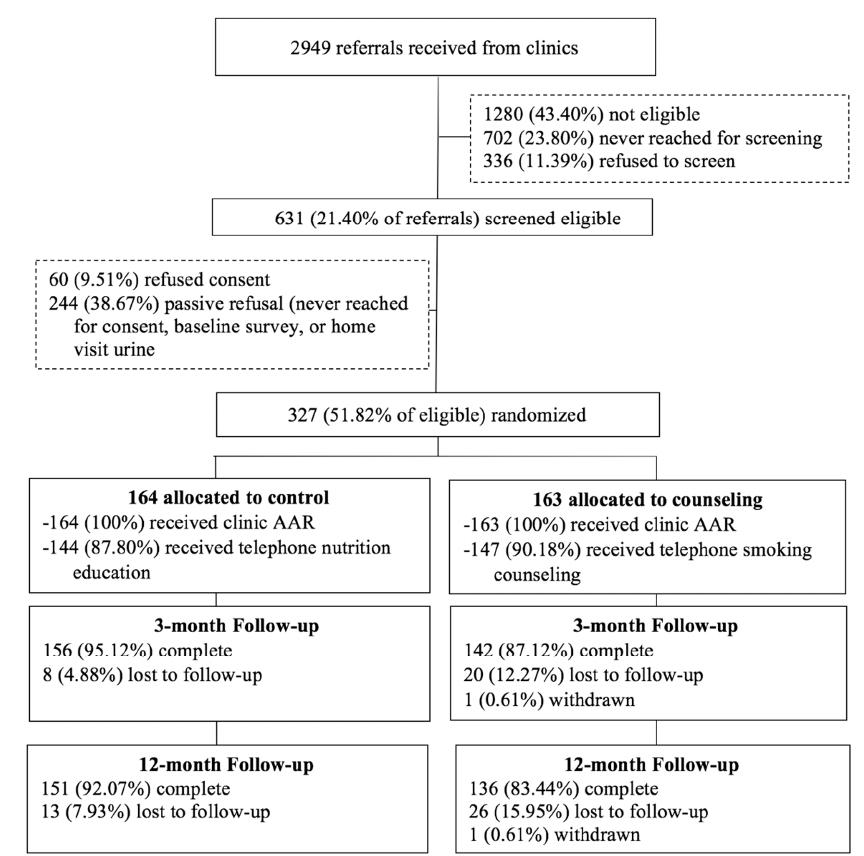
Figure 1. Participant flow chart.